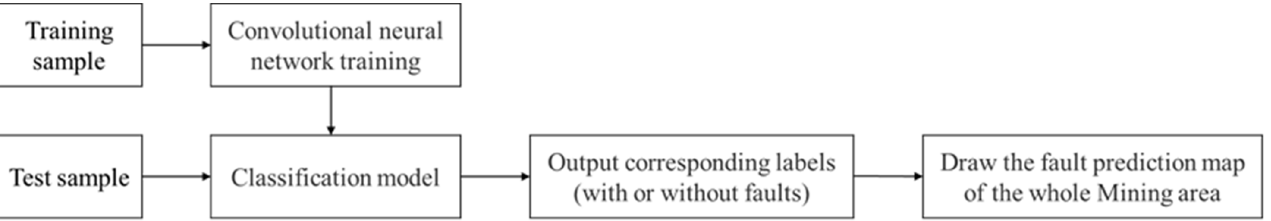
Figure 3. The flowchart of fault identification by CNN.